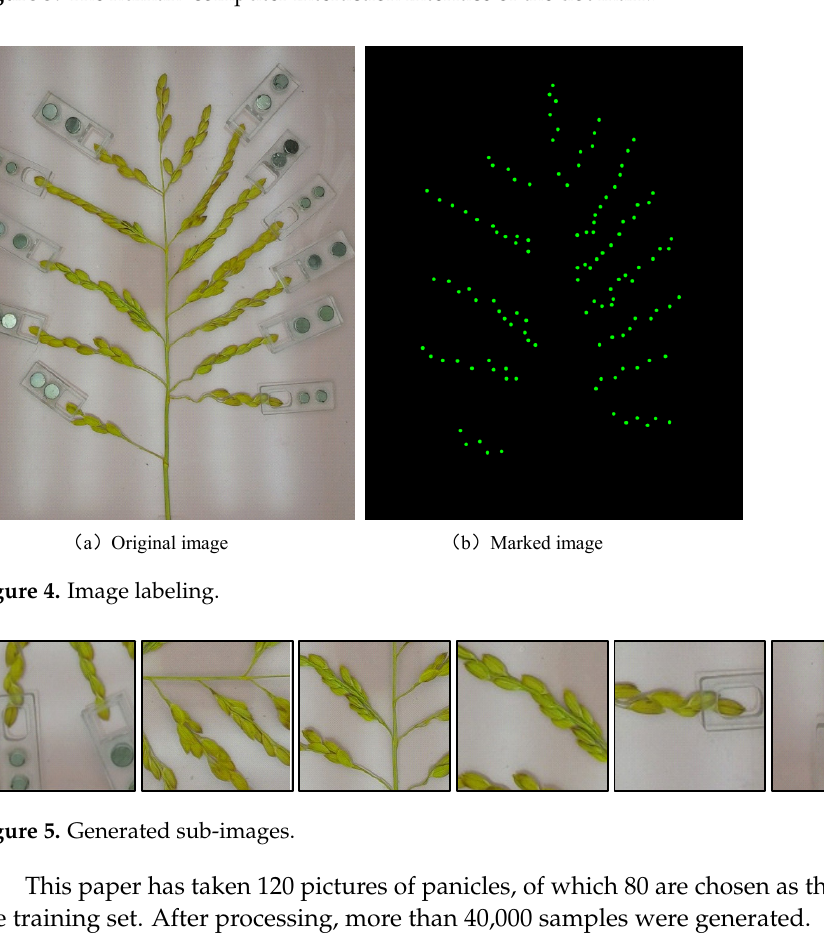
Figure 5. Generated sub-images.